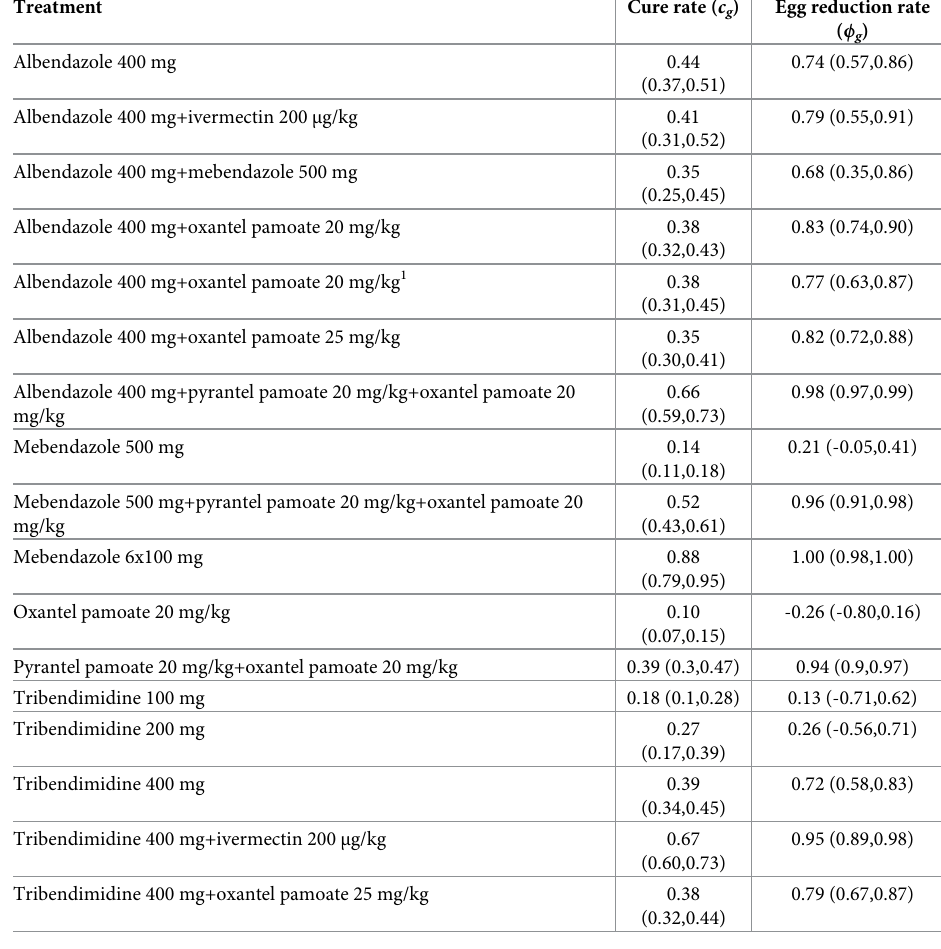
Table 4. Posterior estimates (mean, 95% BCI) for CR and